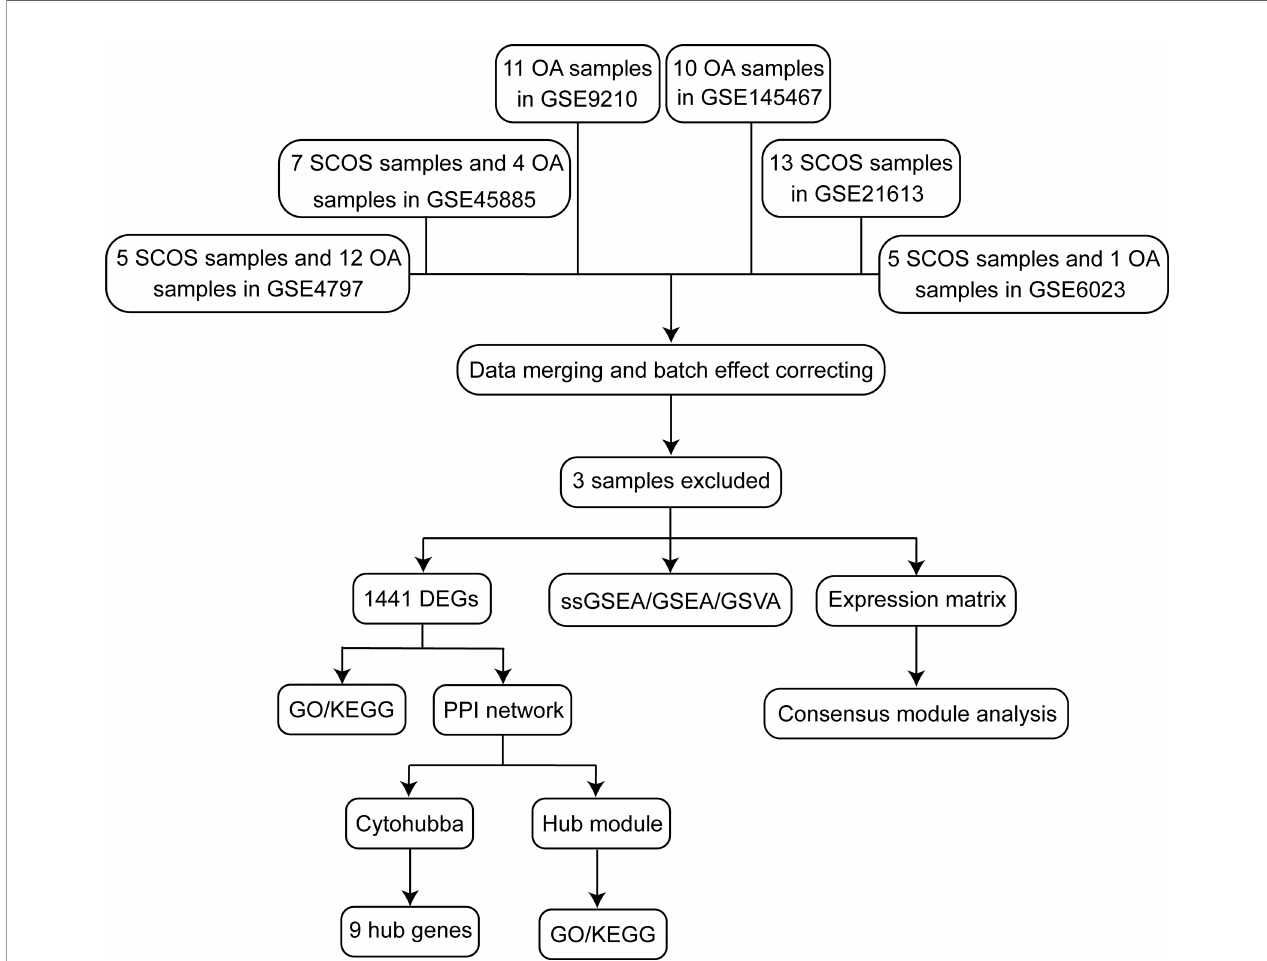
FIGURE 1 | Flowchart of the study design. DEGs, differentially expressed genes; GO, gene ontology; GSEA, gene set enrichment analysis; GSVA, gene set variation analysis; KEGG, Kyoto Encyclopedia of Genes and Genomes; OA, obstructive azoospermia; PPI, protein-protein interaction; SCOS, Sertoli cell-only